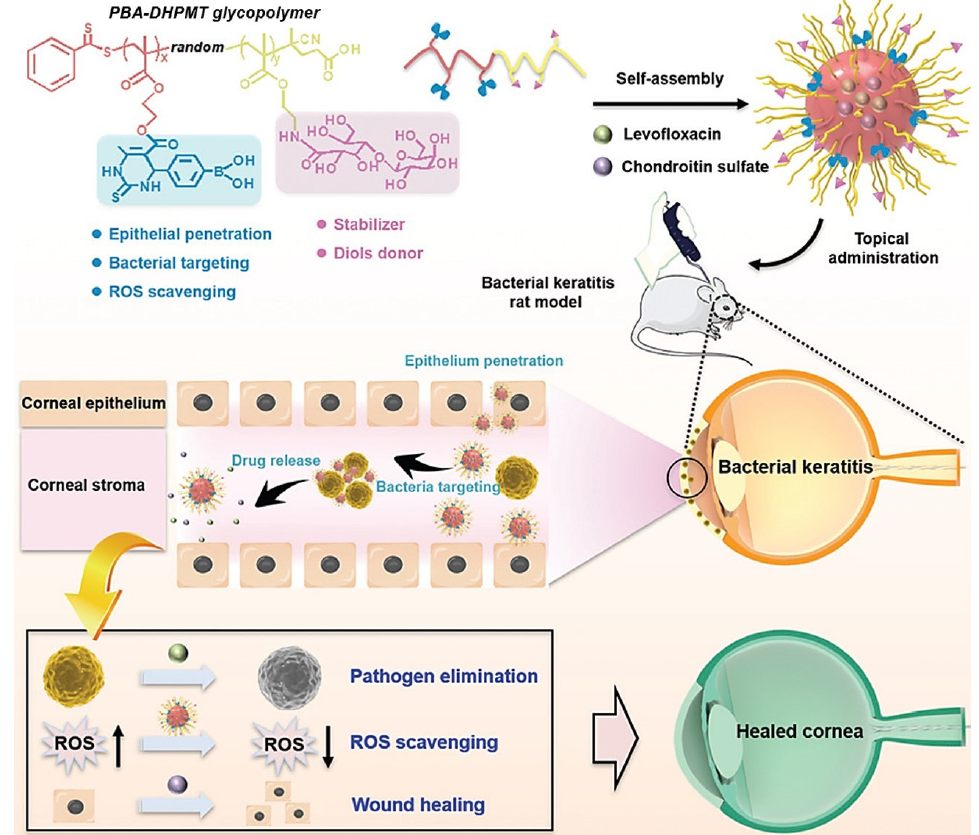
Figure 6. The multi-functional PBA–DHPMT-containing glycopolymeric nanoplatform ( up ) and the therapeutic mechanism of bacterial keratitis in a rat model that combines bactericidal, ROS-scavenging, and wound-healing properties ( down ). Reprinted with permission from ref. [69]. Copyright © 2022 Royal Society of Chemistry. All rights reserved.